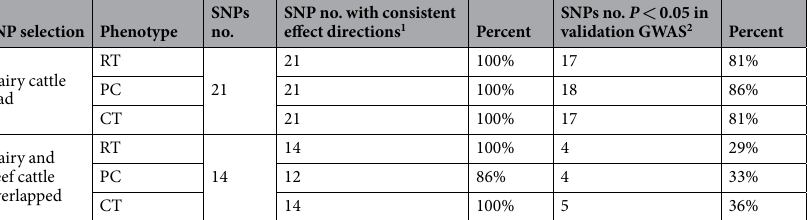
Table 2. Summary of validation for raw traits (RTs), principal components (PCs) and Cholesky transformed traits (CTs). 1 The SNP effects are generated by genome-wide association studies (GWAS) using linear index as phenotype with cow data (validation population) and compared with the effect directions with GWAS of bulls (discovery population). 2 The significance was determined by GWAS using linear index as phenotype with cows (validation population).